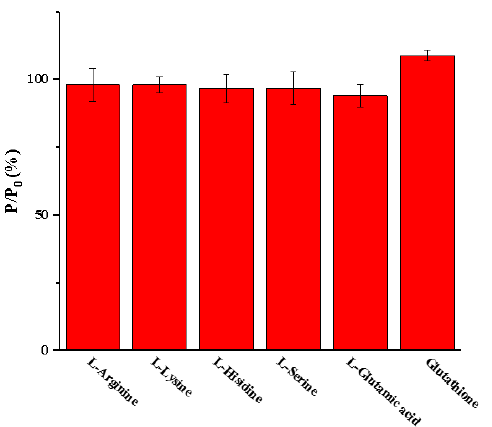
Figure 7. Selectivity of the developed PGM-based method. P/P 0 = the ratio of PGM readout measured